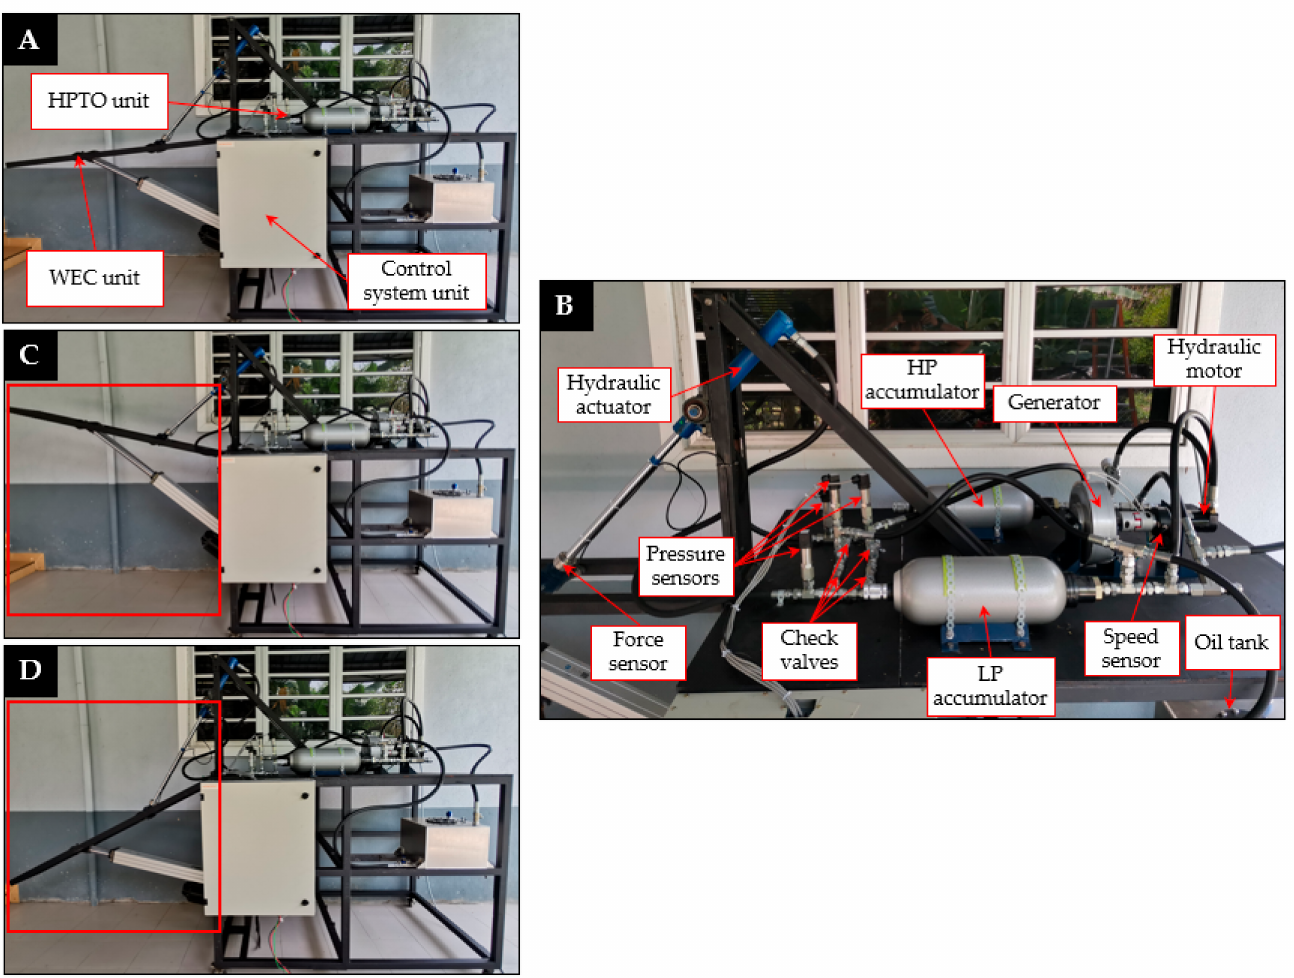
Figure 4. Experimental evaluation of WEC with hydraulic PTO unit. ( A ) A complete dry-lab test rig, ( B ) Enlarge image of HPTO unit setup, ( C ) Maximum upward, and ( D ) Maximum downward position of the WEC